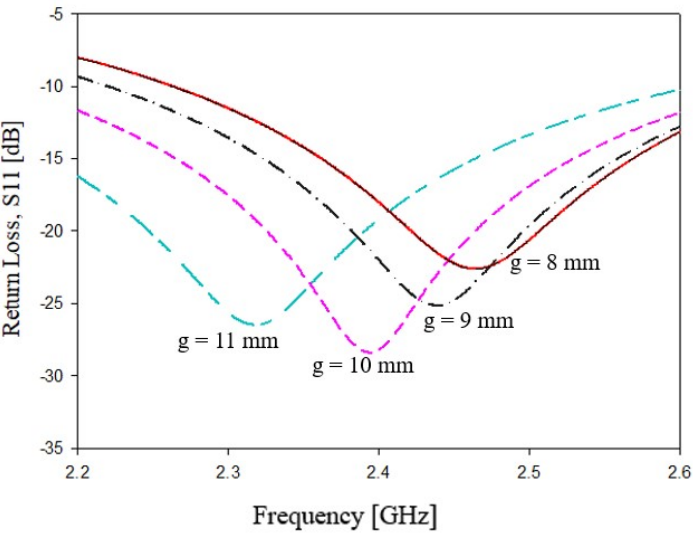
Figure 8. Dependence of the main frequency peak versus variations in stubs gap g , with reference to Figure